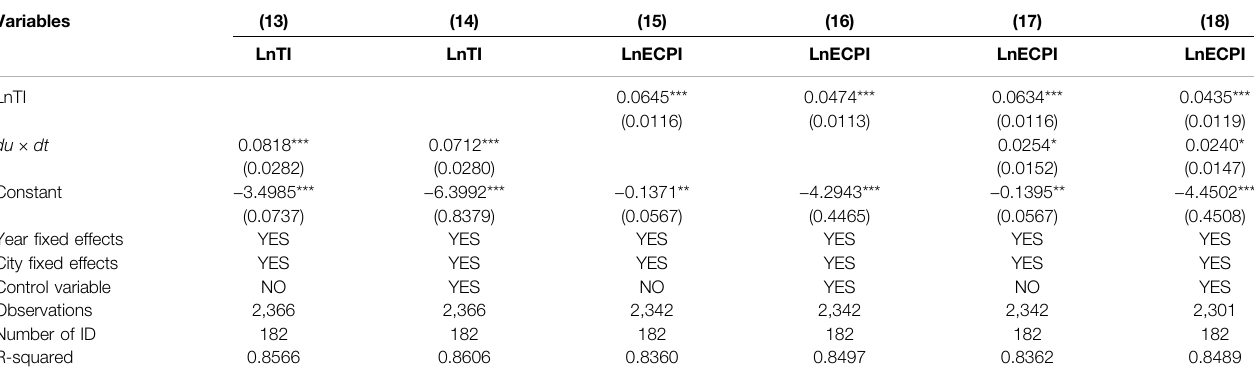
TABLE 6 | Mediating effect test results. Variables